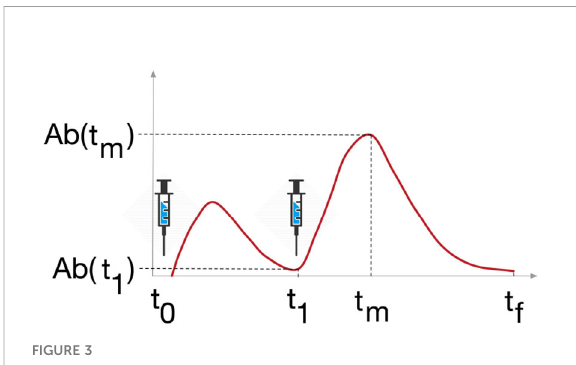
FIGURE 3 Study design. Variables Ab, Plb, Th, Tc and B were analyzed at 3 timepoints, t 1 is the timepoint before the last dose of vaccine, t m is the timepoint when the variable reaches its maximum after the last dose, and t f is the last timepoint of the simulation, 6 months after the last